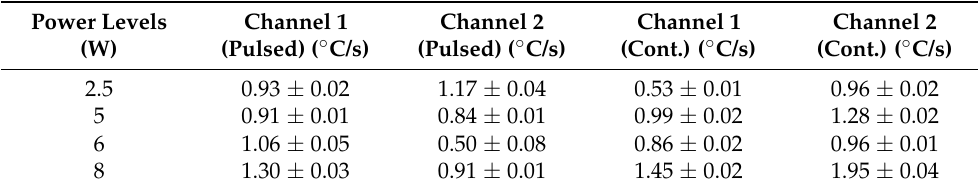
Table 5. Thermal heating coefficients (mean ± SE) at various power levels of LVADs for in vivo measurements.